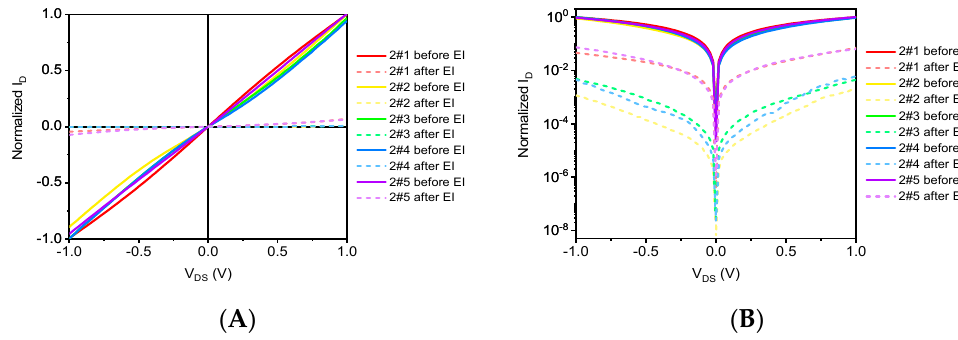
Figure 8. The output characteristic curve of graphene samples before and after electron irradiation. ( A ) Linear coordinates and ( B ) Logarithmic coordinates.